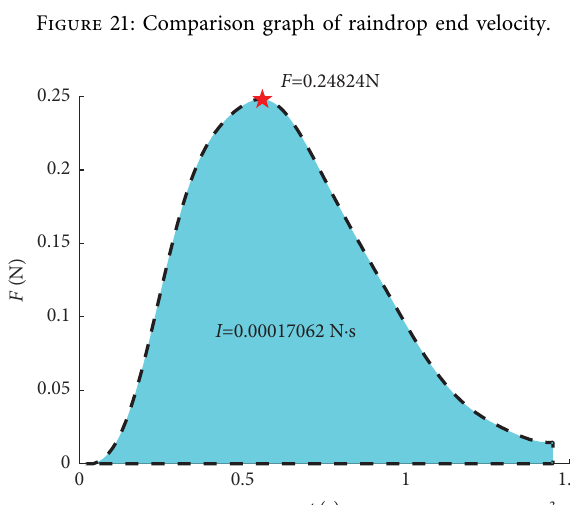
Figure 22: Impact load duration curve of H � 93cm, V